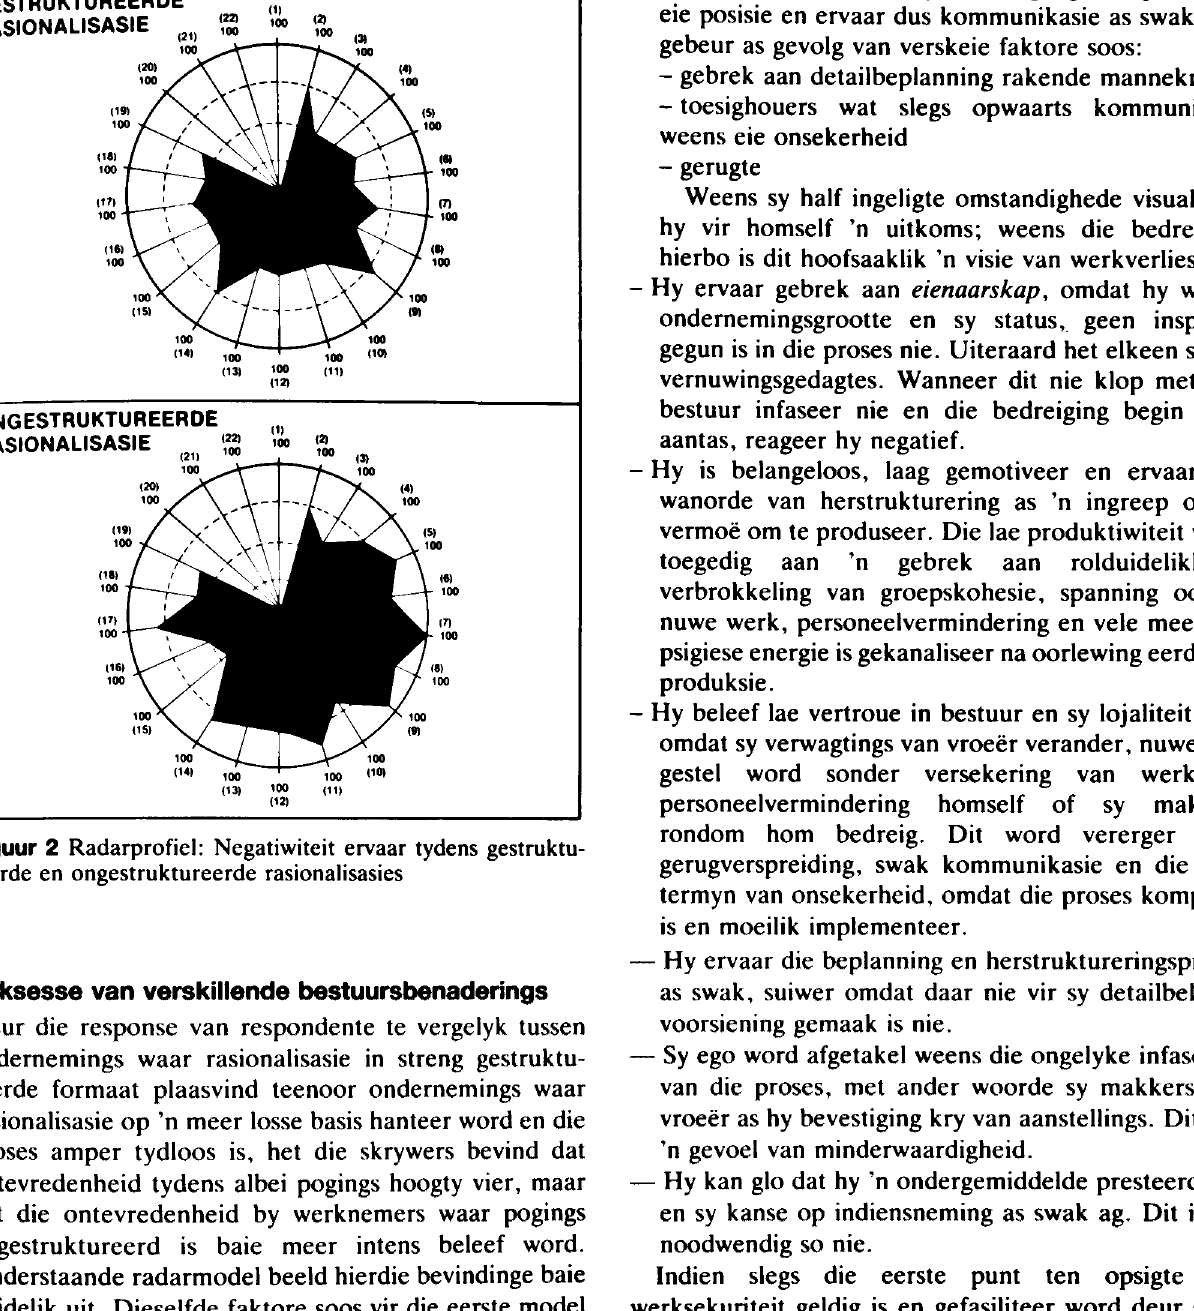
Figuur 2 Radarproficl: Ncgatiwitcit ervaar tydens gcstruktu reerde en ongestruktureerde rasionalisasies